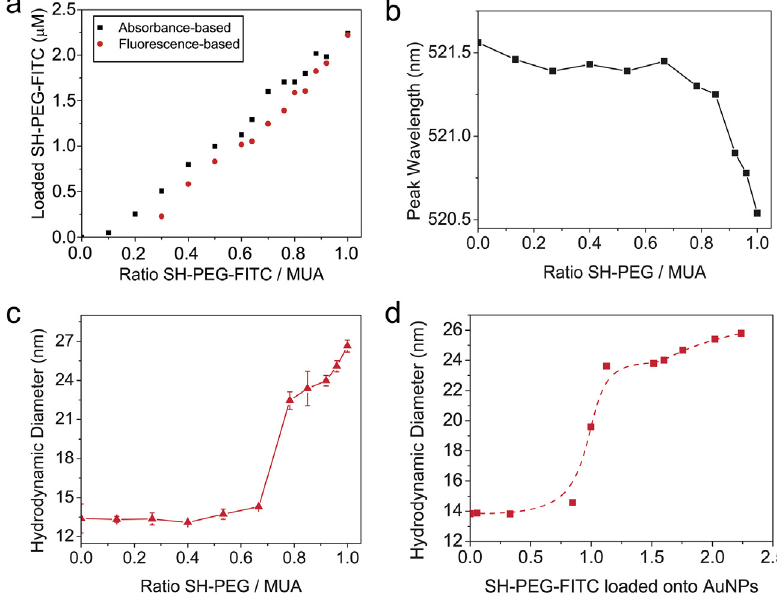
Figure 2 . Mixed layer characterization. (a) Loading of SH-PEG-FITC on AuNPs in function of the ratio SH-PEG-FITC / MUA. In the absorbance-based method, the amount of SH-PEG-FITC on the supernatant was measured after NP removal and subtracted to the initial amount added to know the amount loaded on the NPs. In the fl uorescence based method, the NPs were washed from the excess and digested with NaCN to ultimately measure the fl uorescence of the SH-PEG bond to the NPs. (b) SPR peak in function of the SH-PEG / MUA shows a discontinuous behavior of the SPR shift. This different behavior is due to a change on the SH-PEG conformation. This is corroborated after DLS measures (c). (d) The great raise on the hydrodynamic diameter at loadings ca. 0.9 µM is indicative of the point at which the stretching of SH-PEG chains is